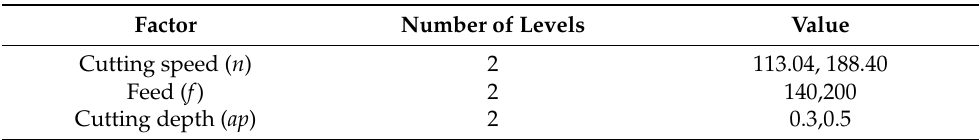
Table 4. Factor and level information.